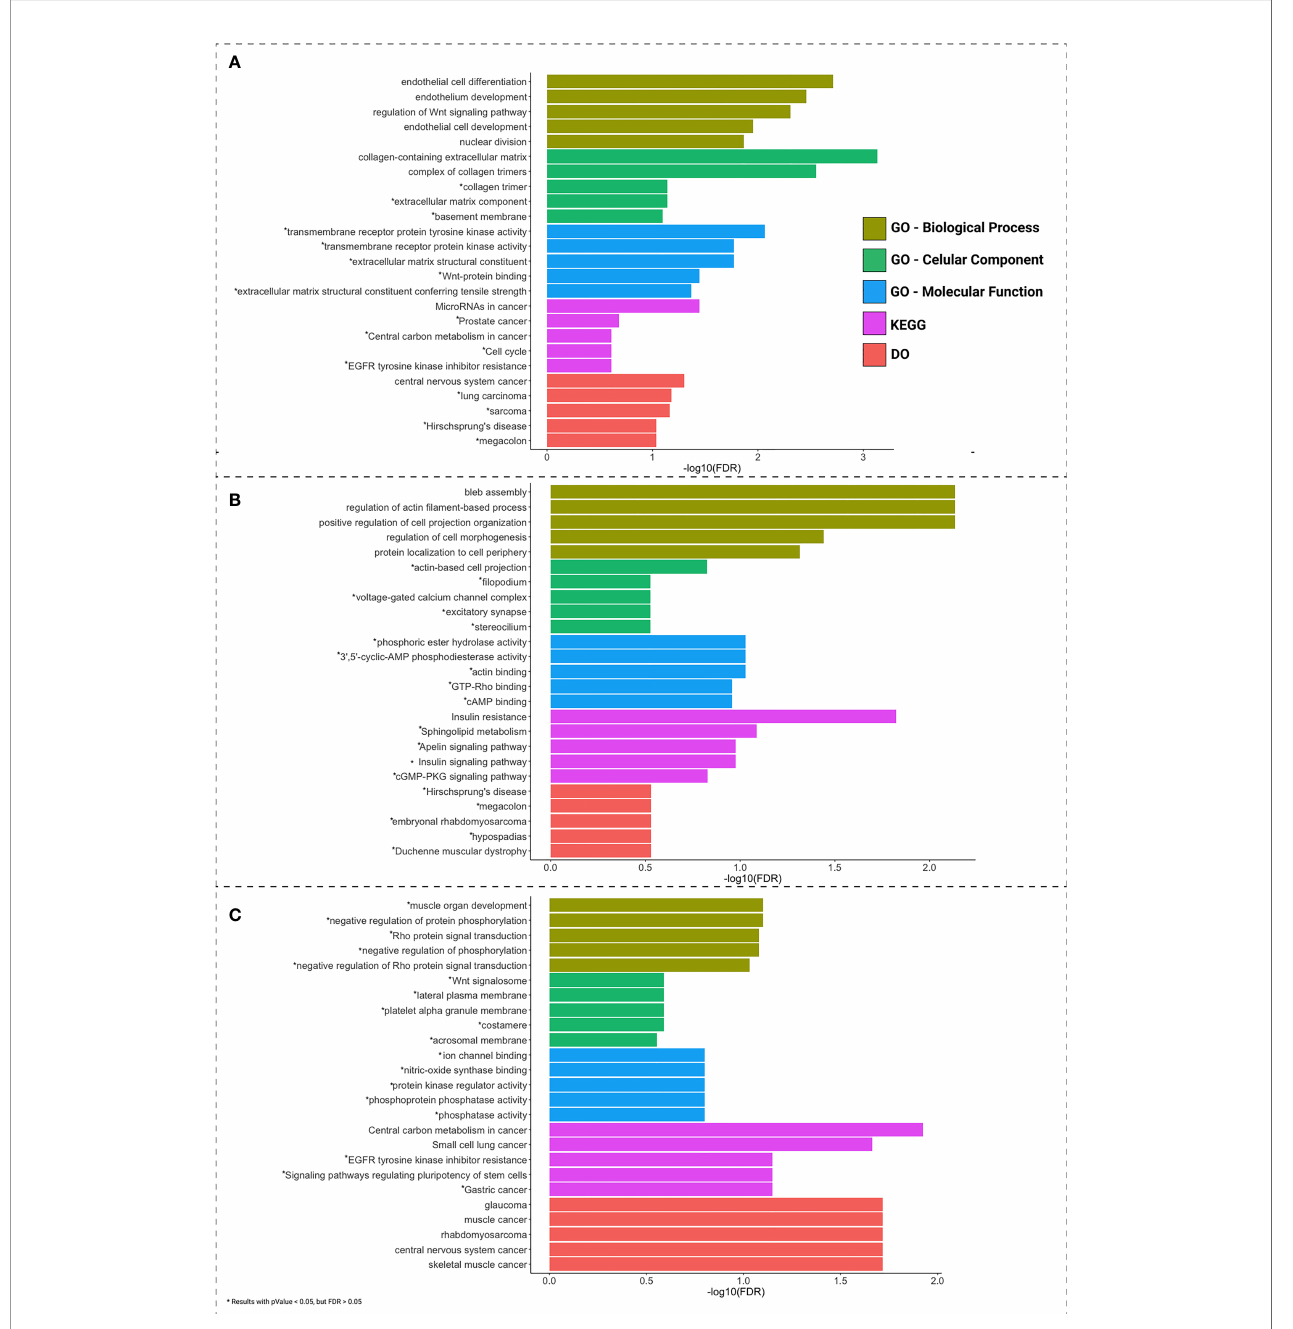
FIGURE 4 | Functional enrichment analysis of PCGs and lncRNAs included in the ceRNA network of colon (A) , rectum (B) , and rectosigmoid junction (C) sites. The top 5 enrichment results for GO biological processes, cellular component, molecular function, DO and KEGG are shown in different colors. Asterisks (*) indicate pathways presenting FDR >